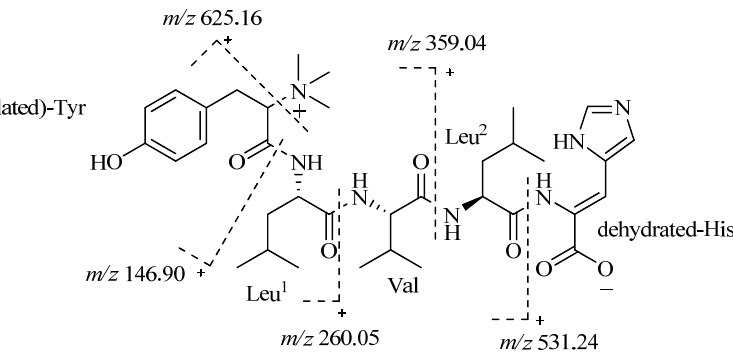
Figure 3. ESI-MS/MS data of 4862F.